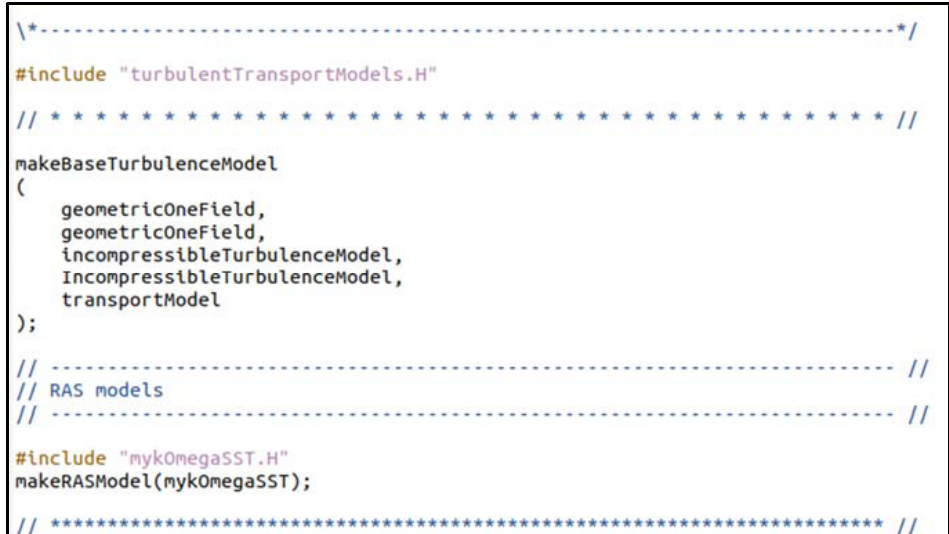
Figure 1. The makeTurbulenceTransportmodels.C file.